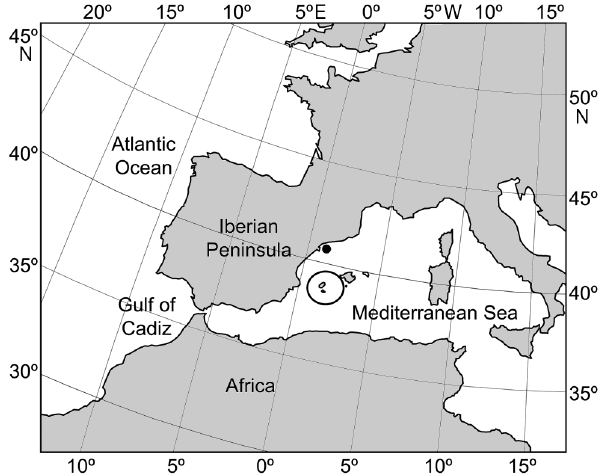
Fig. 1. Approximate location of the Atlantic bluefin tuna Thunnus thynnus farm where the study was conducted (black dot) and the fishing grounds where the fish were caught